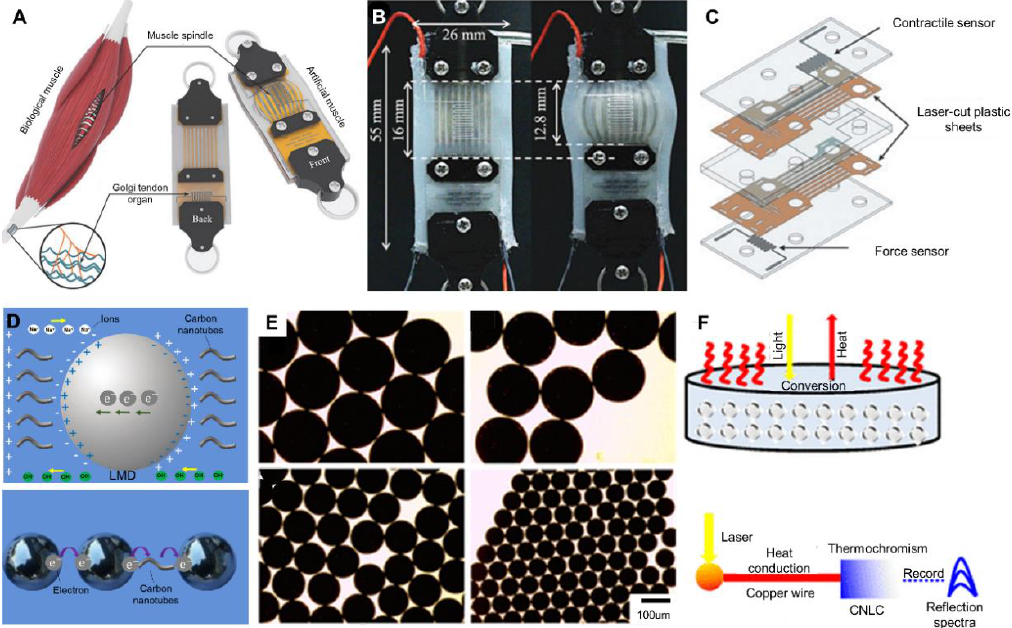
Figure 11. Artificial muscles and liquid metal microsphere sensors. ( A ) Schematic comparison between biological muscle and artificial muscle, reproduced with permission from [136]. ( B ) The sensorized, flat, pneumatic artificial muscle at rest and inflated to 82.8 kPa, reproduced with permission from [137]. ( C ) Illustration of the contraction and pressure sensors, reproduced with permission from [137]. ( D ) The electrical environment of a liquid-metal microsphere in NaOH solution (above) and two methods of communicating for liquid-metal microspheres in a circuit (below), reproduced with permission from [77]. ( E ) Microscopy images showing liquid-metal microspheres produced by capillary-based microfluidics, reproduced with permission from [77]. ( F ) Schematic diagram of the photothermal conversion of liquid-metal microspheres and the near-infrared (NIR) sensor based on the liquid metal microsphere, reproduced with permission from